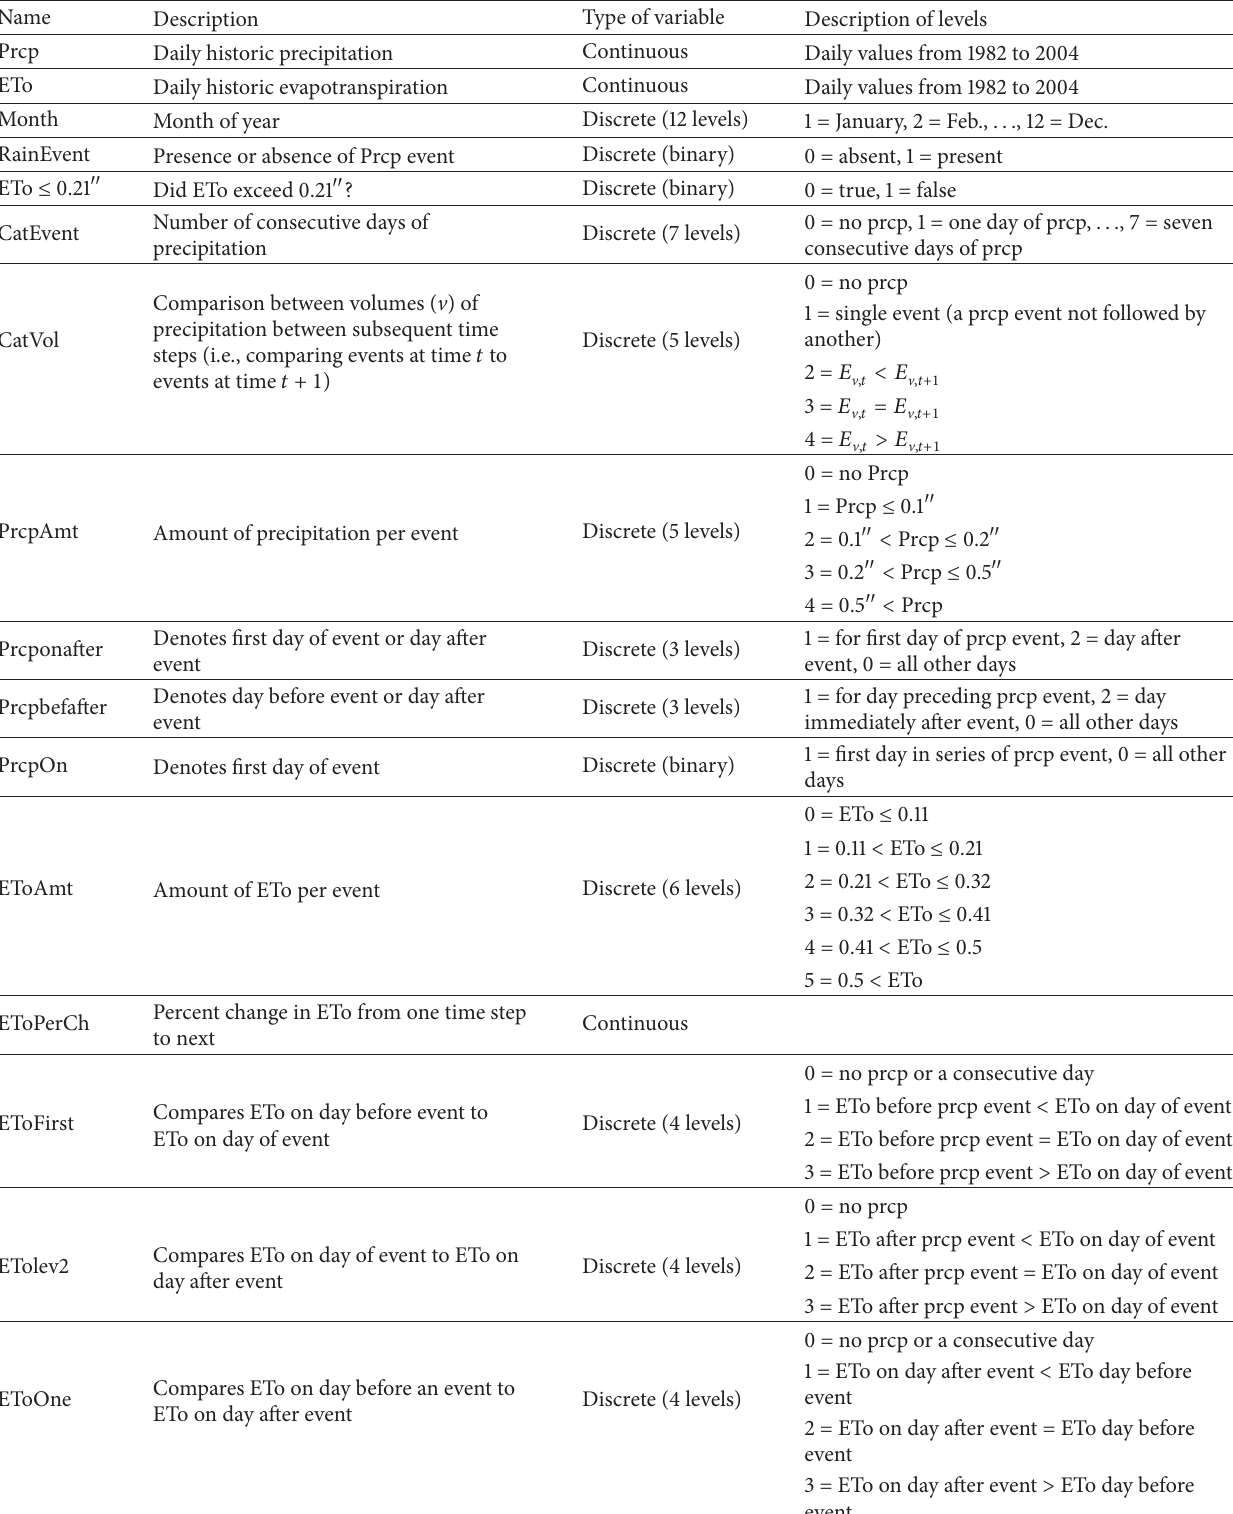
Table 2: Description of variables used for the statistical analyses. Note that event refers to days in which precipitation occurred, either as a one day occurrence or as multiple contiguous